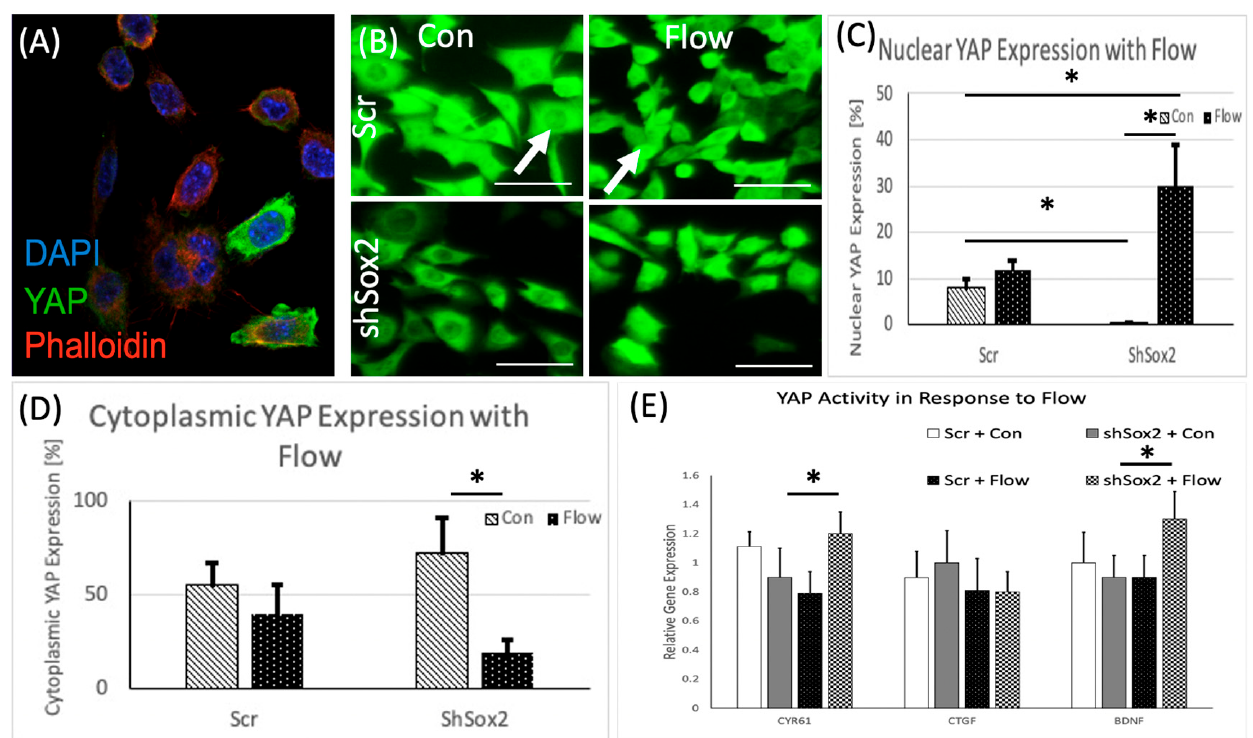
Figure 2. Evaluation of YAP localization and activity as a function of fluid flow induced shear stress (FFSS). ( A ) Representative immunofluorescence image showing staining for YAP (green), actin (red) and nuclei (blue). ( B ) Immunofluorescence images of YAP (green) staining in scr and shSox2 cells under control and FFSS conditions; scale bar = 20 µ m. Quantification of ( C ) nuclear ( D ) cytoplasmic YAP localization in scr and shShox2 treated cells under control and FFSS conditions. ( E ) Gene expression data for downstream targets of YAP with FFSS * p < 0.05; p value from Mann–Whitney test for statistical significance .